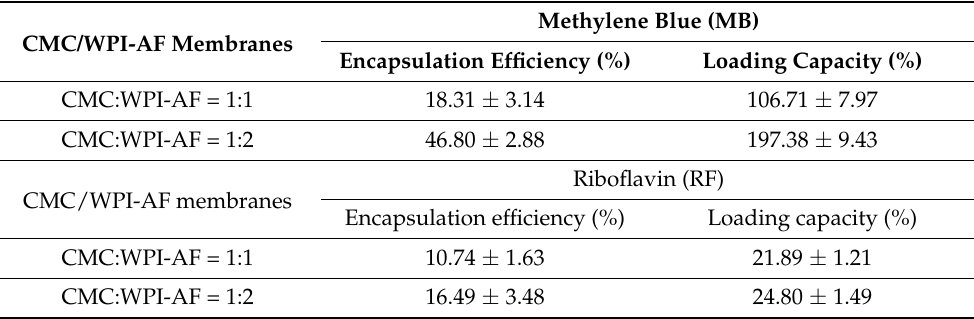
Table 1. A listing of the encapsulation efficiency and loading capacity of CMC/WPI-AF membranes on methylene blue and